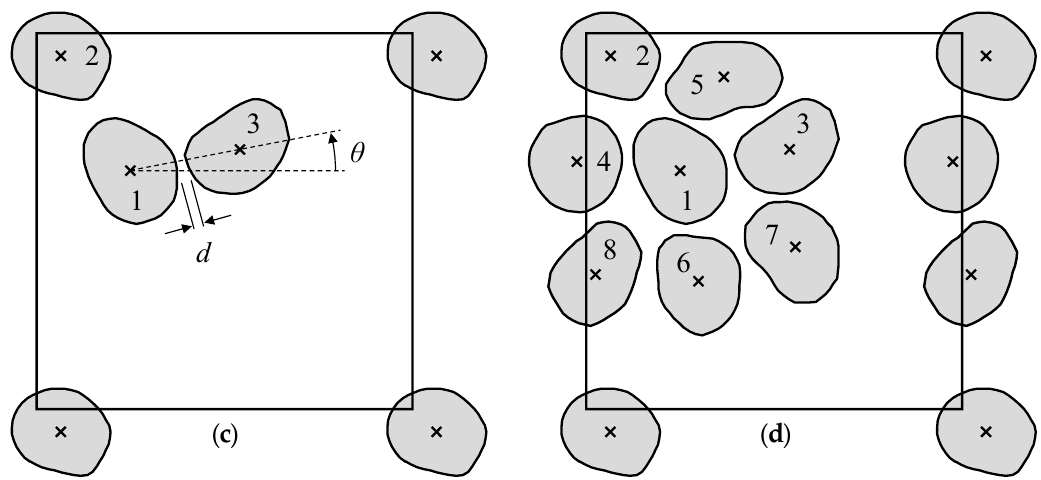
Figure 3. Schematic illustration of the RSE algorithm with actual fibers: ( a ) step 2, ( b ) step 3, and ( c , d ) step 4.